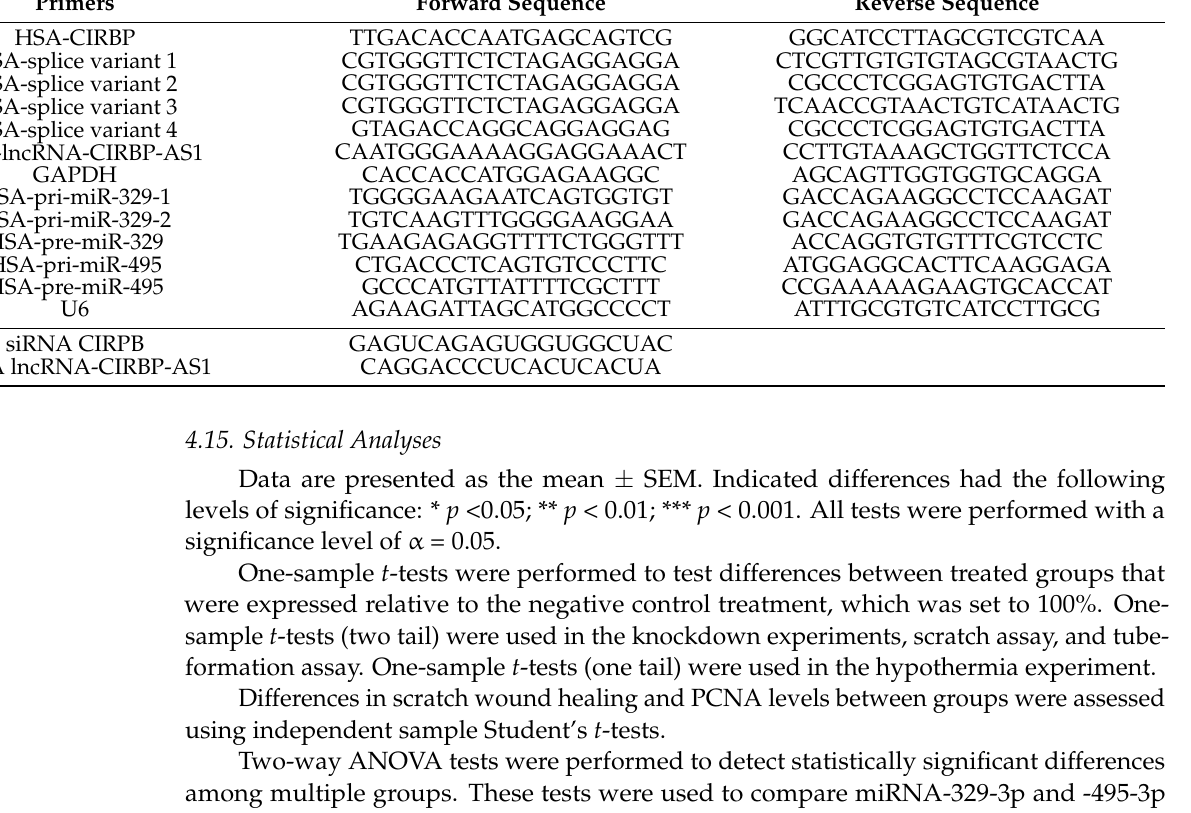
Table 1. Sequences of primers used for qPCR and the siRNAs used for knockdown. Primers Forward Sequence Reverse